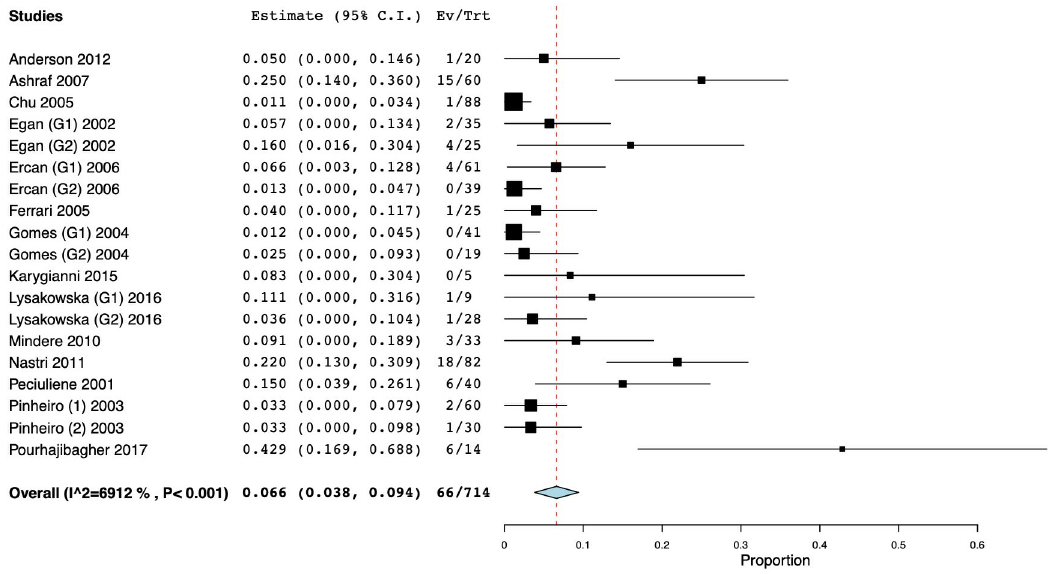
Fig 8. Forest plot representing fungal species prevalence in teeth with primary and secondary endodontic infections assessed via cultural methods in systemically healthy subjects.